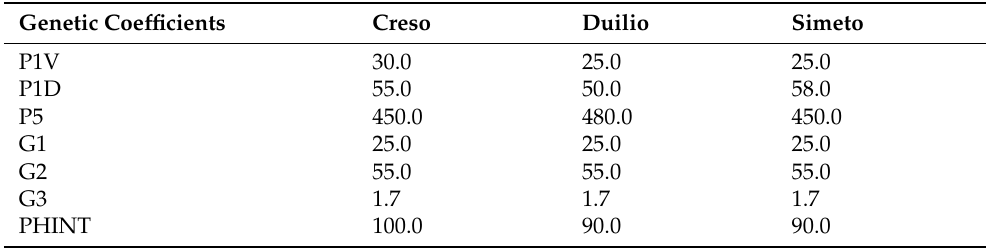
Table 2. Genetic coefficient values for Creso, Duilio, and Simeto durum wheat varieties during CERES-Wheat model calibration using data collected at two experimental sites located in Southern Sardinia, Italy [45]. P1D: Photoperiod sensitivity coefficient (% reduction/h near threshold); P1V: Vernalization sensitivity coefficient (%/d of unfulfilled vernalization); P5: Thermal time from the onset of linear filling to maturity ( ◦ C d); G1: Kernel number per unit stem + spike weight at anthesis (#/g); G2: Standard kernel size under optimum conditions (mg); G3: Standard, non-stressed dry weight (total, including grain) of a single tiller at maturity (g); PHINT: Thermal time between the appearance of leaf tips ( ◦ C d). Genetic Coefficients Creso Duilio Simeto